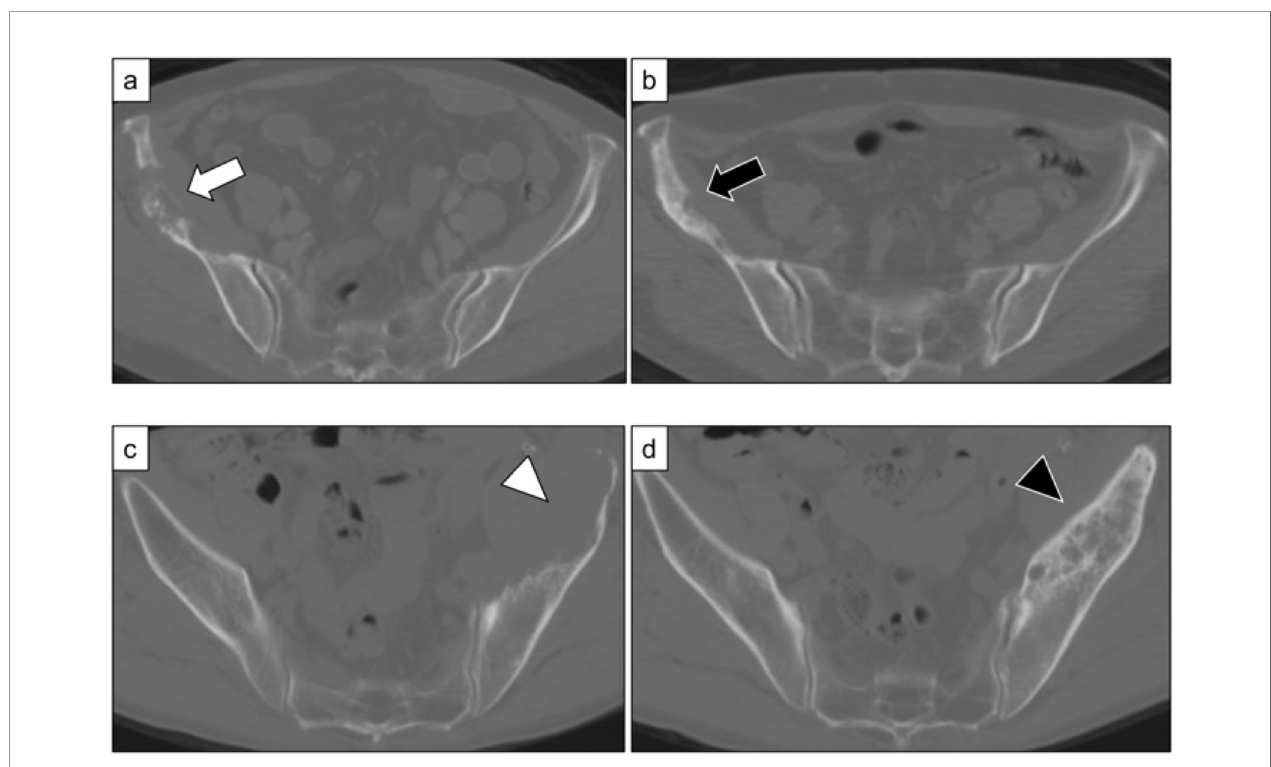
FIGURE 1 | (A) Metastatic bone lesions in the right ilium of a 77-year-old woman (Case 17). (B) Osteosclerotic changes three months after treatment with pembrolizumab and denosumab. The patient was in partial remission (MDA criteria). (C) Metastatic bone lesions in the left ilium of a 64-year-old man (Case 29). (D) Osteosclerotic changes fi ve months after treatment with pembrolizumab and denosumab. The patient was in partial remission (MDA